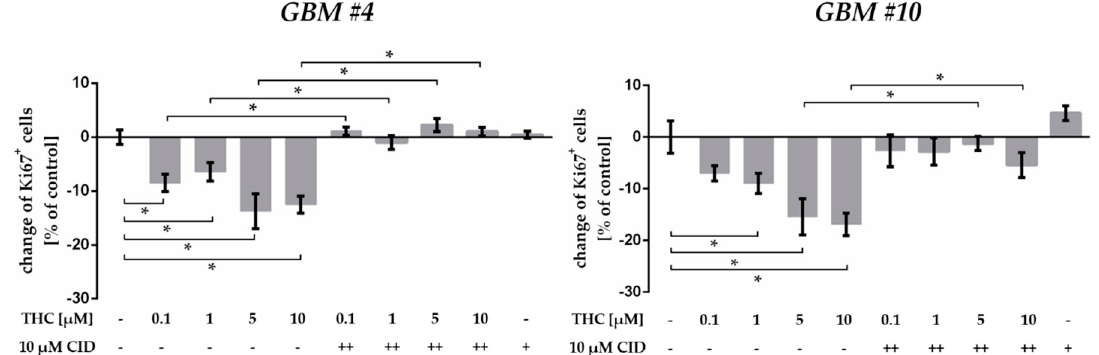
Figure 5. Effects of increasing THC concentrations in presence of GPR55 antagonist CID16020046 (CID). In comparison to the untreated control group, application of different THC concentrations (0.1–10 µ M) for 24 h led to a significant reduction in the number of Ki67 + cells in GBM #4 and GBM #10 . The Ki67-reducing effects of THC were effectively attenuated when CID (10 µ M) was co-applied, whereas CID alone induced no alterations. To block the GPR55 receptor, we applied CID 15 min (++) before THC was subsequently added. Data are means ± SEM of N = 3 independent experiments performed in duplicate. Significance was chosen for p < 0.05. The asterisk denotes significant results regarding the respective measurement indicated with the bar.